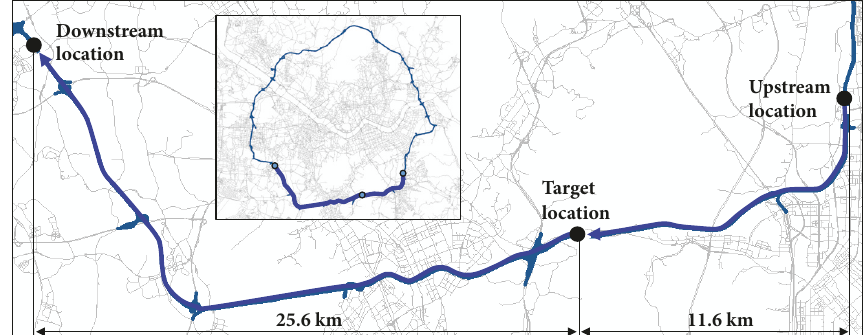
Figure 3: Test bed.